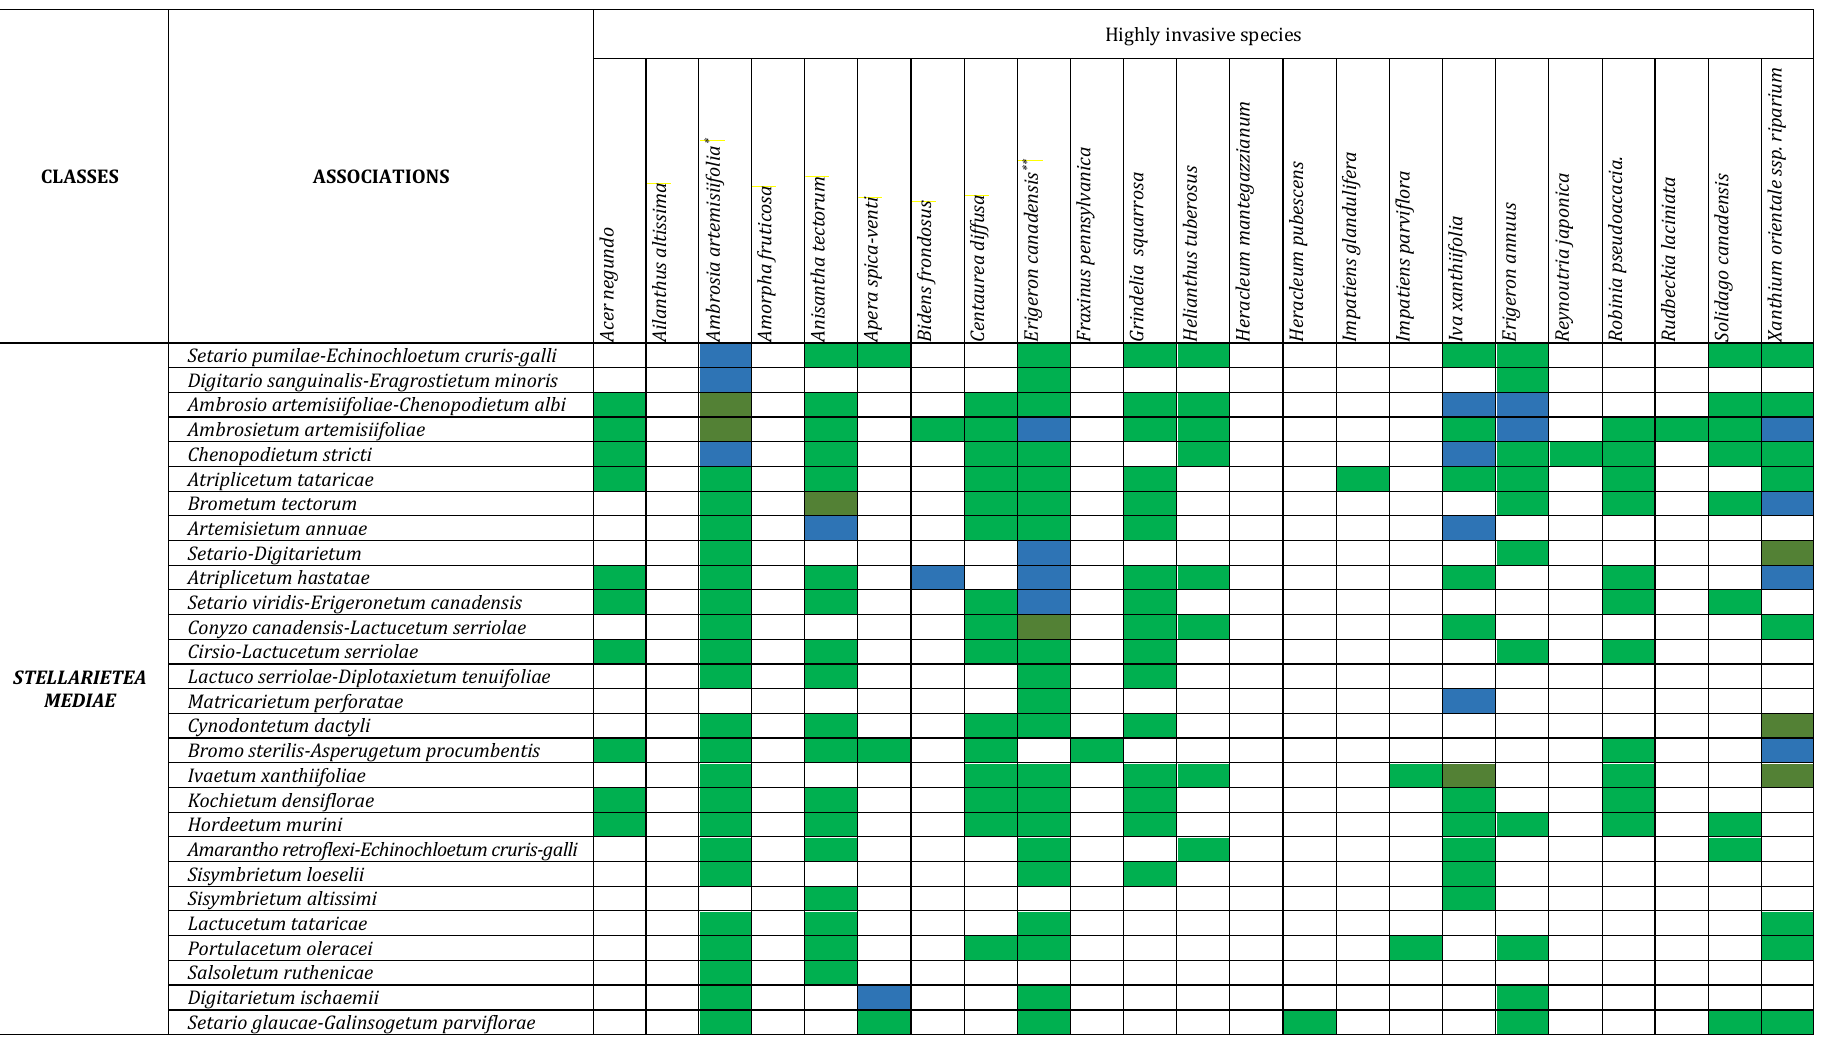
Table 4. Participation of highly invasive species in different ruderal plant communities of